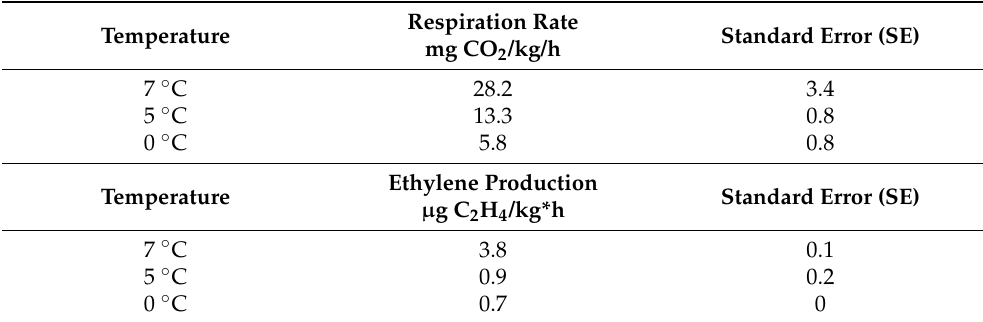
Table 3. Respiration rate and ethylene production in goji berries at different temperatures using five replicates of each temperature measurement.